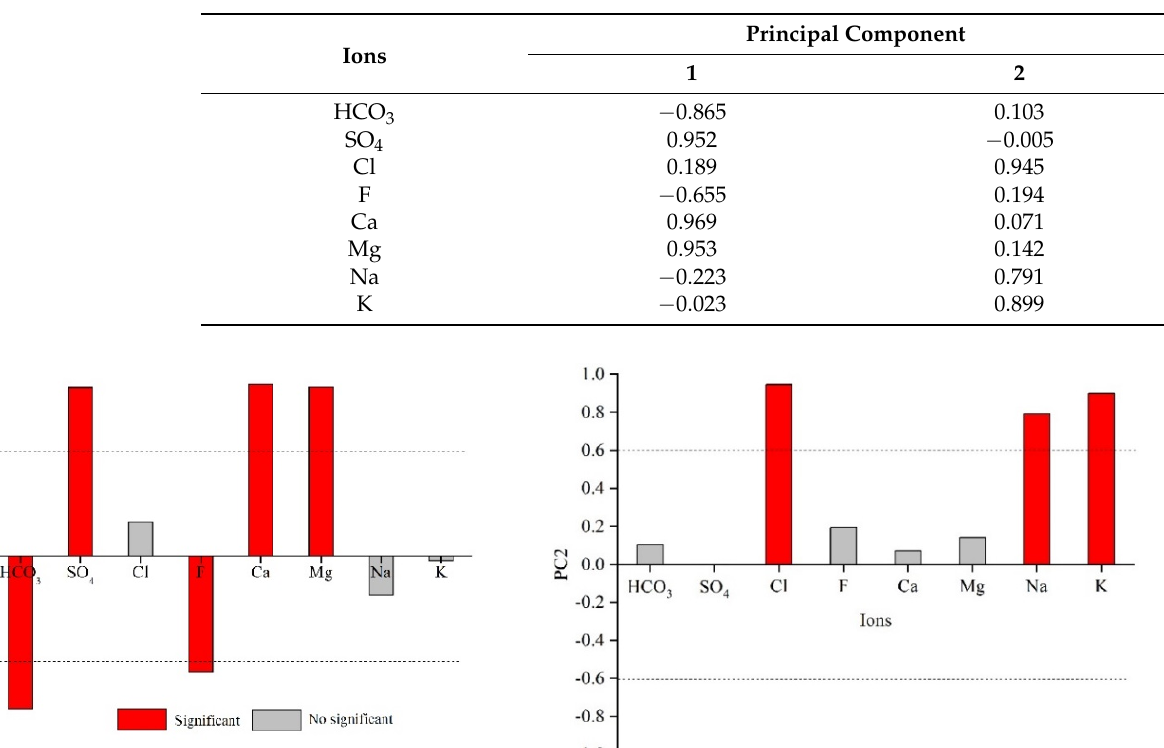
Table 4. Correlation coefficient for each principal component.